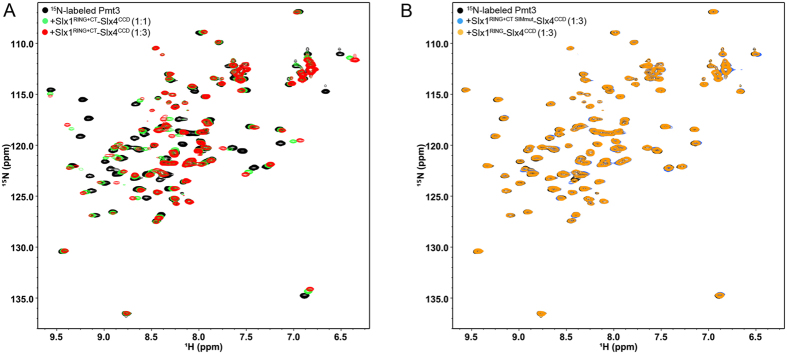
NMR titrations of Slx1RING+CT-Slx4CCD, Slx1RING-Slx4CCD, or Slx1RING+CT SIMmut-Slx4CCD into 15N-labeled Pmt3.(A) Overlay of 1H-15N HSQC spectra of Pmt3 amide resonances in the free (black) and in the presence of Slx1RING+CT-Slx4CCD with molar ratios 1:1 (green) and 1:3 (red). Chemical shift changes indicate the binding between Pmt3 and Slx1RING+CT-Slx4CCD. (B) Overlay of 1H-15N HSQC spectra of Pmt3 amide resonances in the free (black) and in the presence of Slx1RING-Slx4CCD (orange) and Slx1RING+CT SIMmut-Slx4CCD (blue) with molar ratios 1:3.